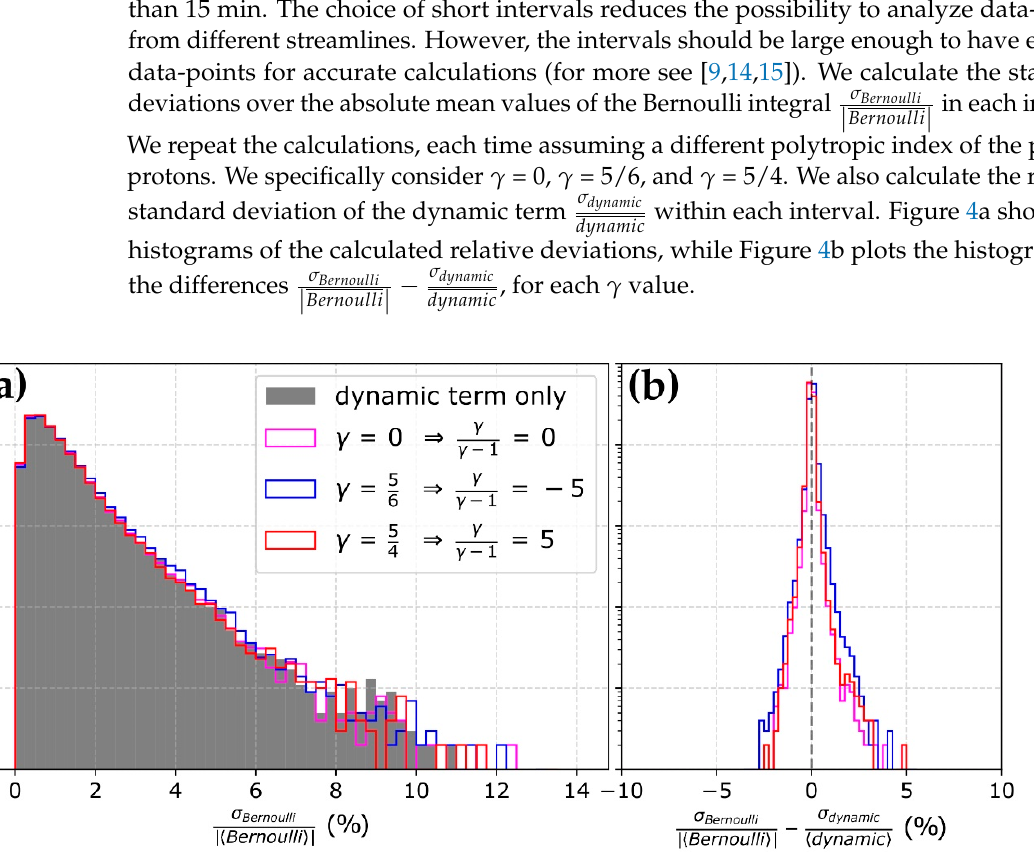
Figure 4. ( a ) Histograms of the relative standard deviations (standard deviations over the absolute mean values) of the Bernoulli integral within short time intervals observed in 1995. We calculate the Bernoulli integral assuming (magenta) γ = 0, (blue) γ = 5/6, and (red) γ = 5/4. The grey histogram shows the relative deviation of the dynamic term 1 of the differences between the Bernoulli integral relative deviation and the relative deviation of the dynamic term within the selected intervals.